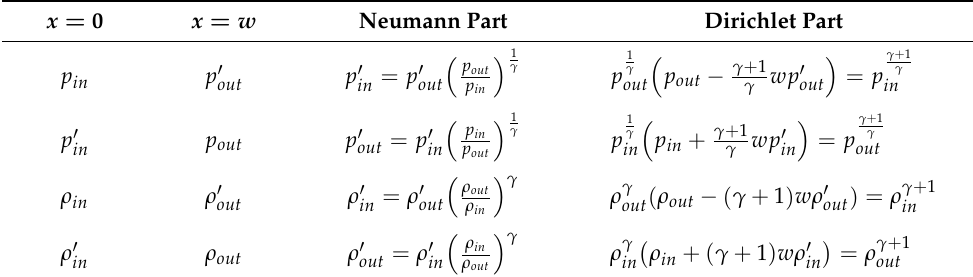
Table 2. Overview of equations used to reformulate mixed BVPs as either Dirichlet or Neumann BVP.